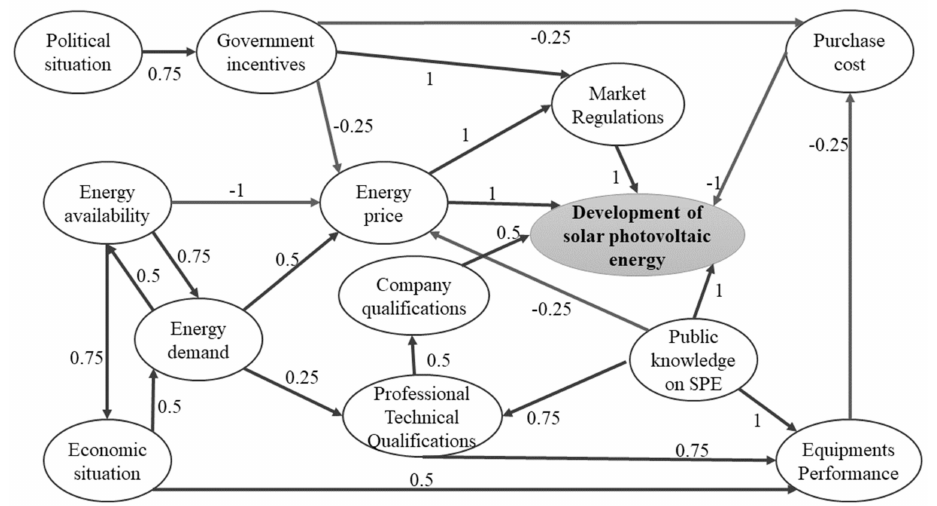
Figure 1. Example of a fuzzy cognitive map created from a group of specialists for Brazilian photovoltaic solar energy development. Republished with permission from Papageorgiou et al. [7]; Published by MDPI,